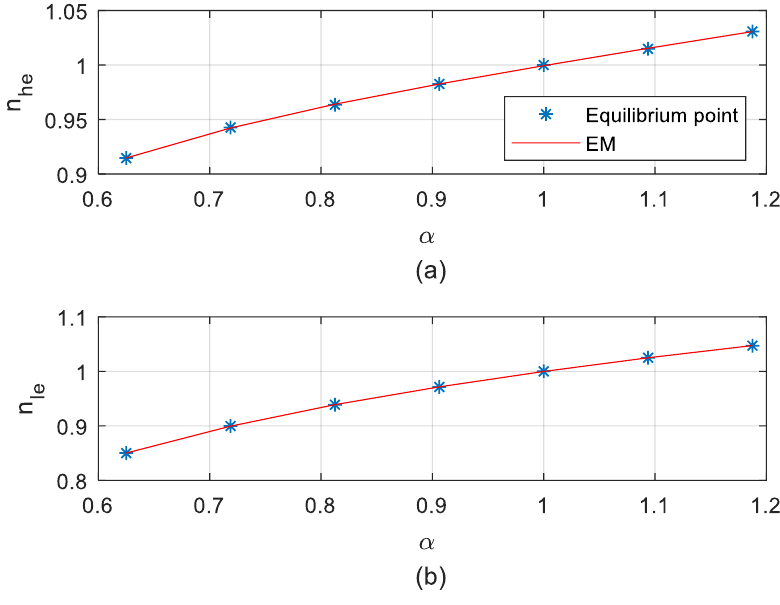
Figure 2. ( a ) EM of 𝑛 ℎ𝑒 ; ( b ) EM of 𝑛 𝑙𝑒 . Figure 2. (a) EM of n he ; (b) EM of n le